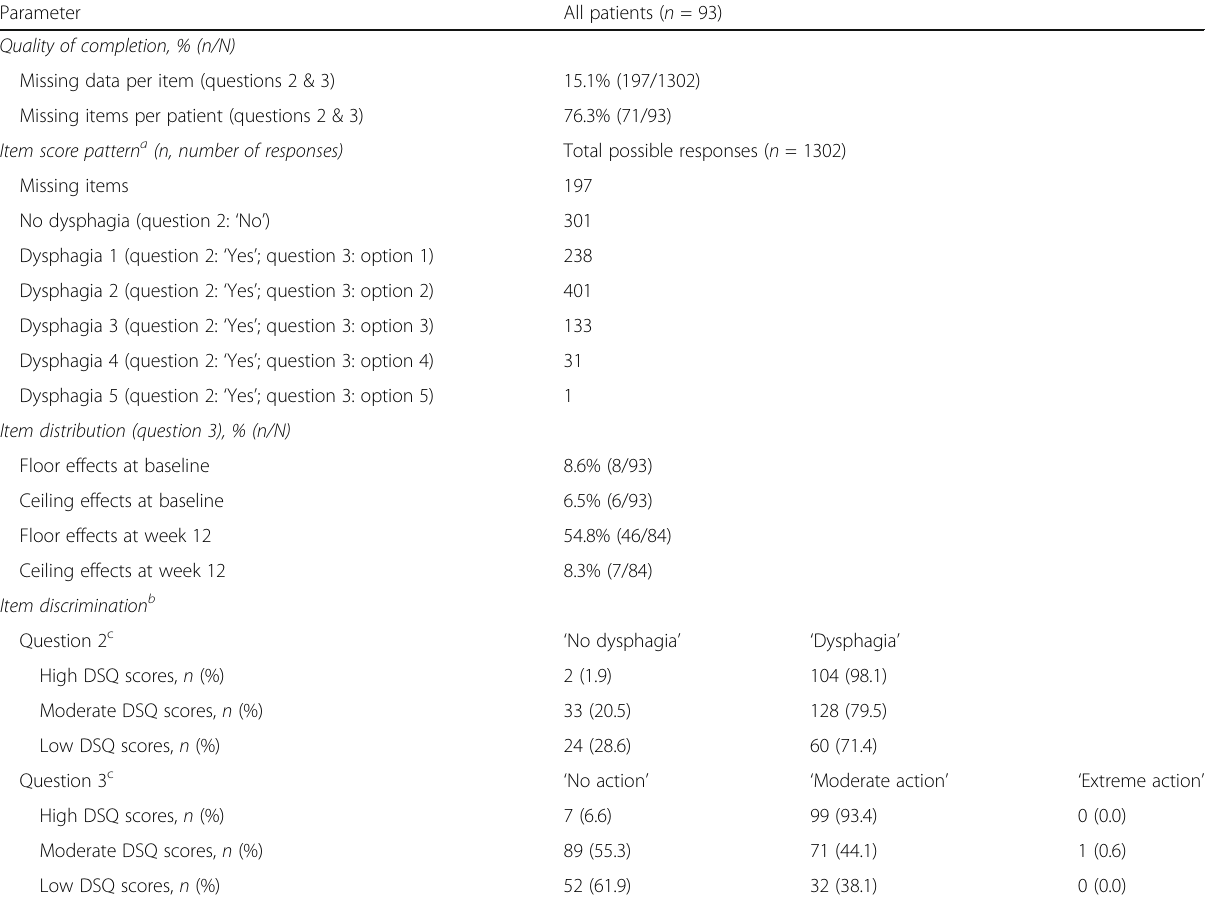
Table 3 Stage 1: Item analysis of the DSQ (version 4.0) to assess quality of completion by patients, item score patterns, item distribution and item discrimination at baseline (visit 2) in patients with EoE. Floor and ceiling effects at the end of the